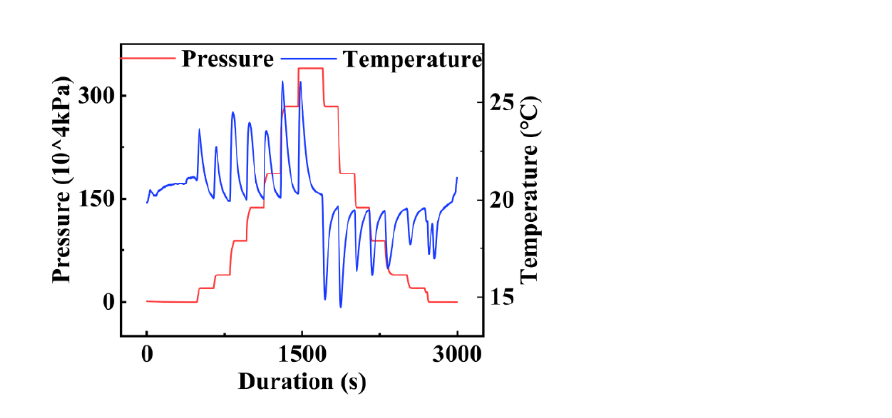
Figure 20. Comparison of the temperature and pressure results of the pressure calibration experi- ment.